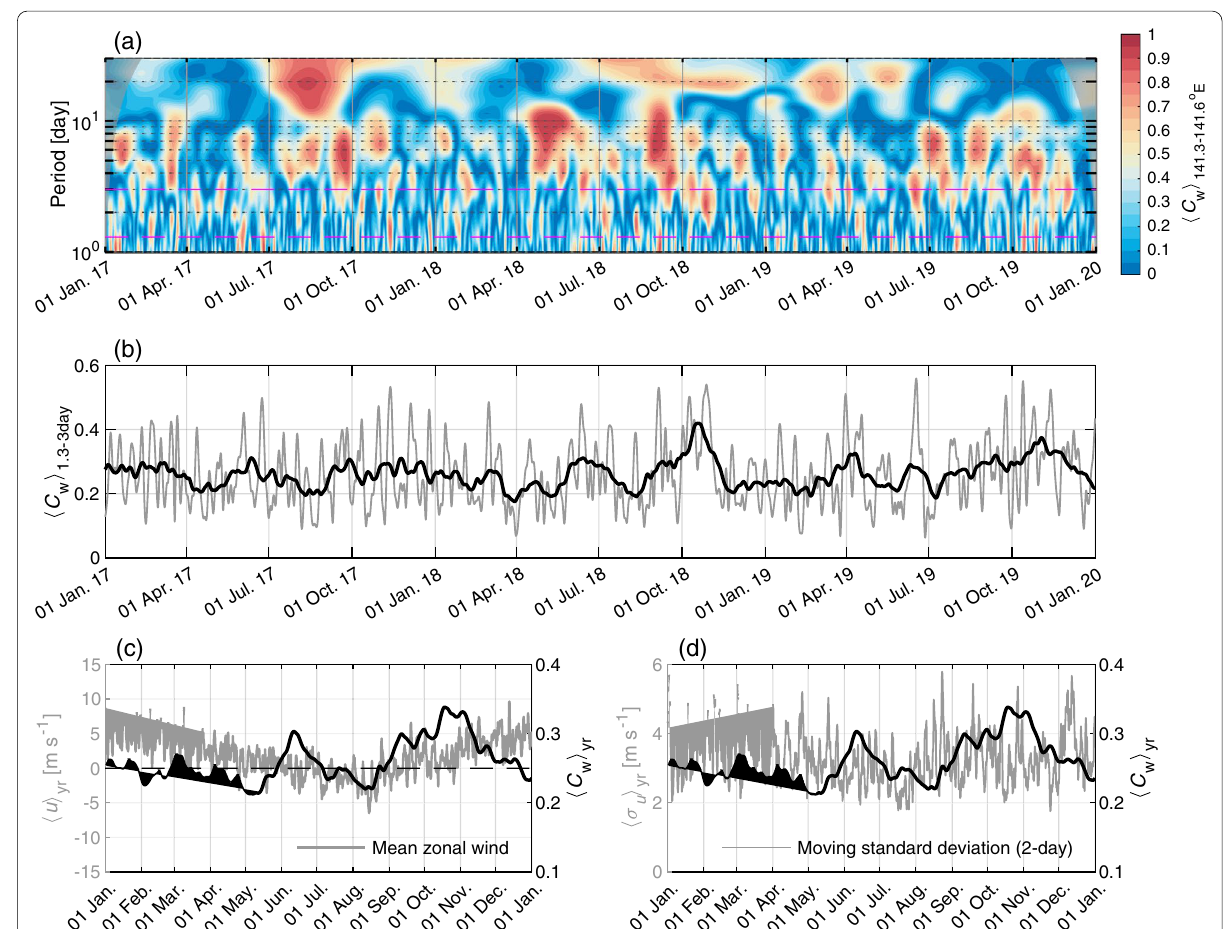
Fig. 15 a Wavelet coherence in the axis variation with the spatial mean of zonal wind for each point (141.3–141.6°E mean). b Seasonal variation in a statistical average (from 1.3 to 3.0 days) of the coherence shown in ( a ). c and d : Seasonal variation in the coherence shown in b compared to seasonal variation in the spatial mean of zonal wind and 3-yr mean of moving standard deviation of the spatial mean zonal wind for each year,